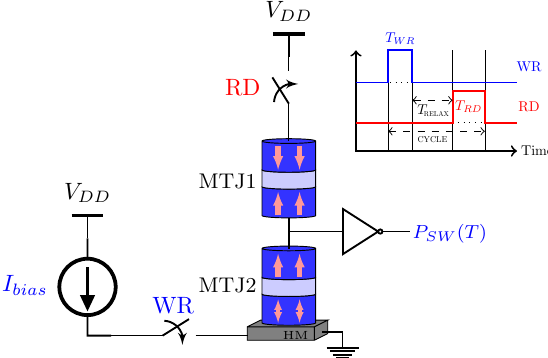
Figure 19. The MTJ-based temperature sensor proposed in Reference